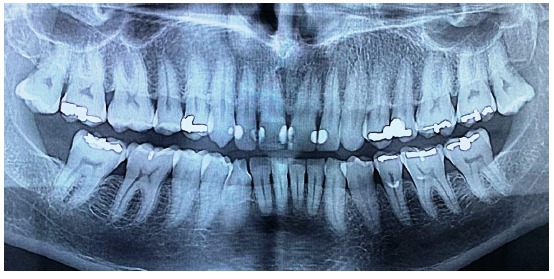
Radiograph aspect.